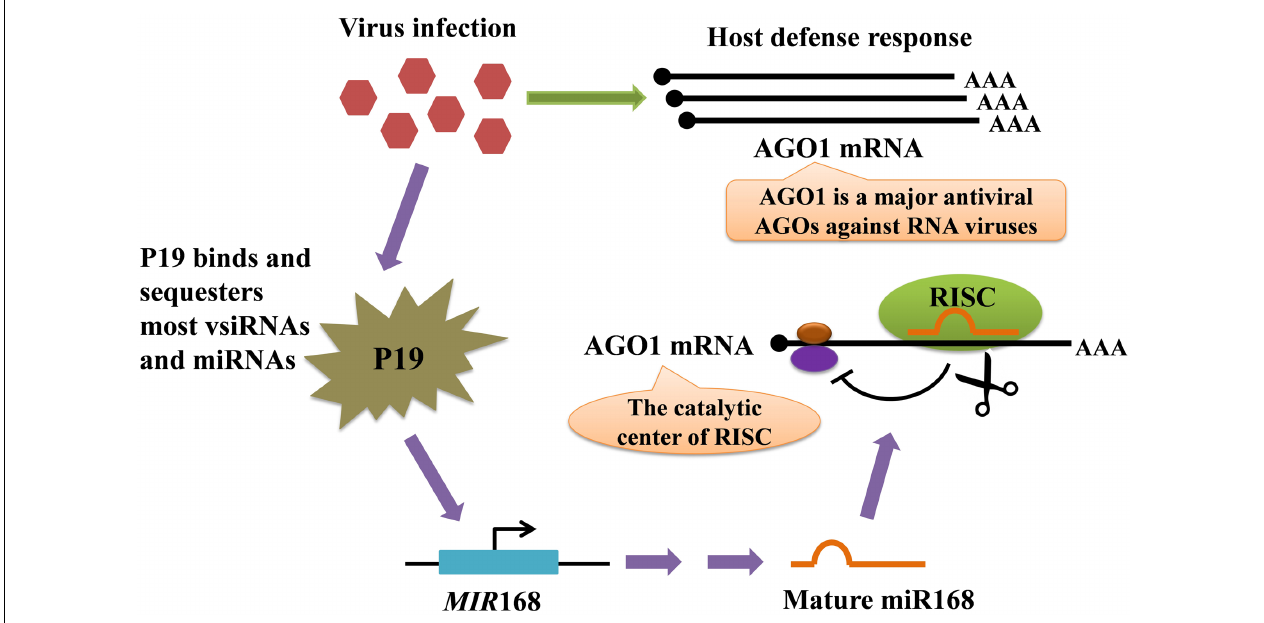
FIGURE 3 | Model for the regulation of the AGO1 mRNA level mediated by tombusviral protein P19-induced miR168. The AGO1 protein plays a central role in plant defensive response against pathogens, and viral infection induces enhanced expression of AGO1 mRNA. Meanwhile, the virus produces the P19 VSR. P19 forms head-to-tail homodimers that bind to virus-encoded siRNAs (vsiRNAs), siRNAs and endogenous miRNAs with high affinity, preventing their loading into AGO1. However, miR168 is not efficiently bound by P19, resulting in the increased loading of miR168 into AGO1. Because miR168 directly represses the AGO1 mRNA, the accumulation of antiviral AGO1 is sharply decreased. In addition, tombusvirus infection also stimulates MIR 168 transcription, and the expression of AGO1 mRNA is consequently further repressed by the increased miR168 level. Therefore, P19 VSR can not only sequester small RNAs, but can also effectively inhibit the loading of viral siRNAs onto